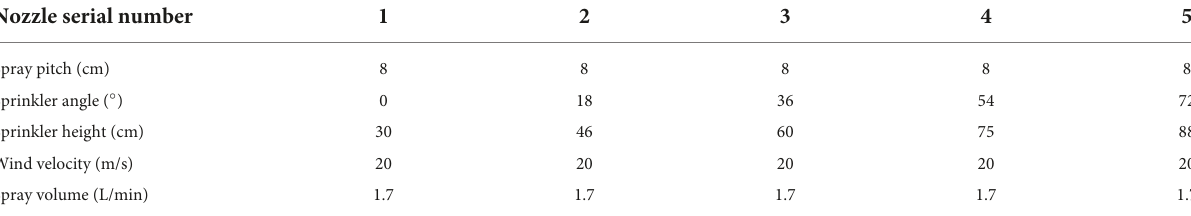
TABLE 3 List of nozzle parameters from No. 1 to 5.